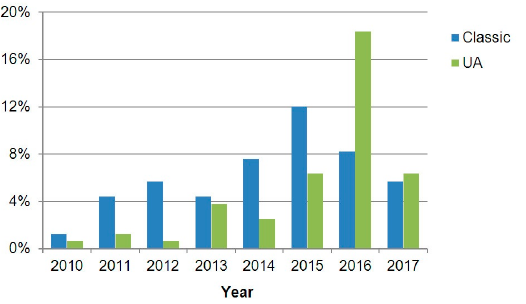
Figure 13. Distribution of the OPC specification usage in the reviewed contributions over time.